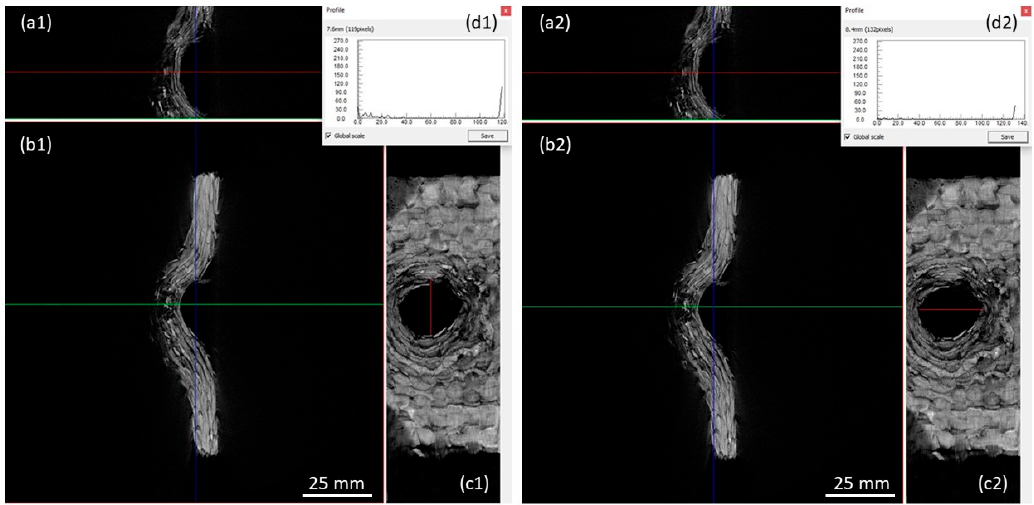
Figure 9. Slices and top view of the E-glass fabric reinforced geopolymer composite after impact test in longitudinal ( a1–c1 ) and transverse ( a2–c2 ) directions (the lines indicate where the other cross sections were taken). ( d1–d2 ) The response from the damaged area.